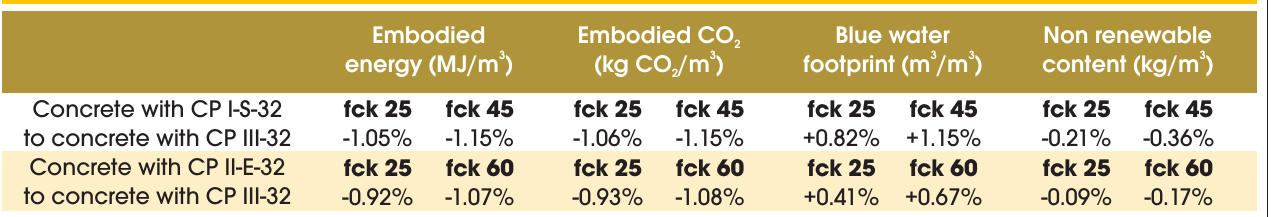
Table 2 – Variations on each indicator's values for every 1% replacement of clinker with ggbs